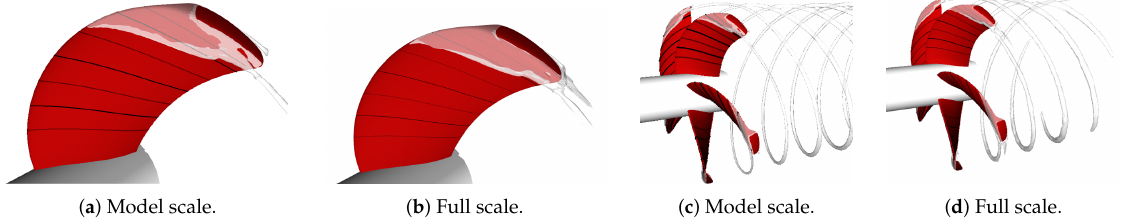
Figure 29. Comparison of the predicted cavitation patterns for the TLP in model- and full-scale conditions. Both results are from SST